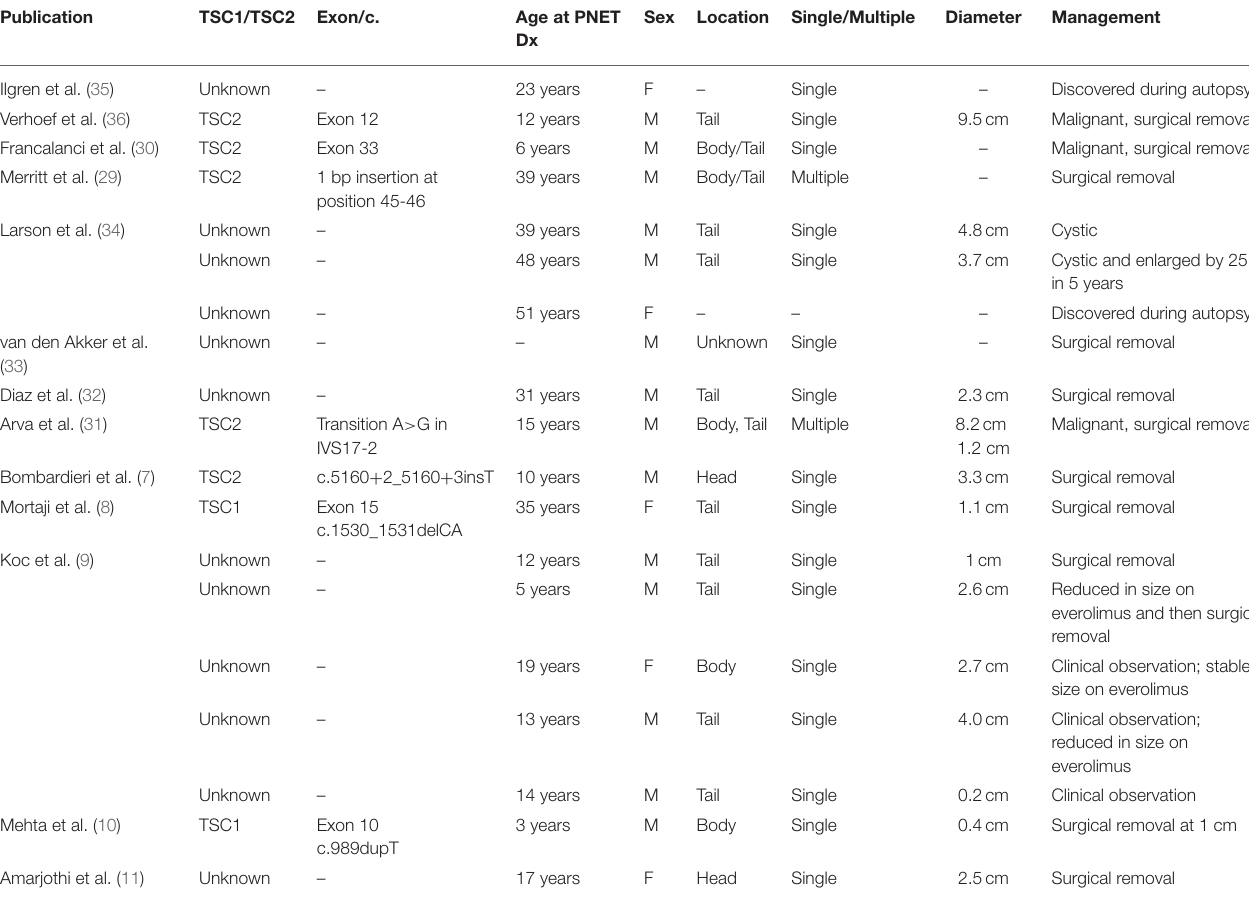
TABLE 2 | Clinical information from individuals with TSC diagnosed with nonfunctional PNETs reported in the medical